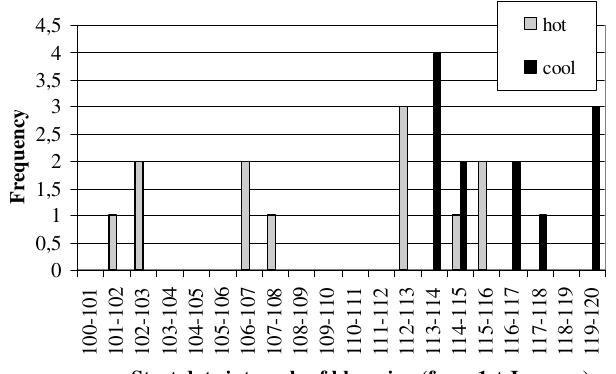
Figure 4. Distribution of the start date of sour cherry blooming at hot and cool years